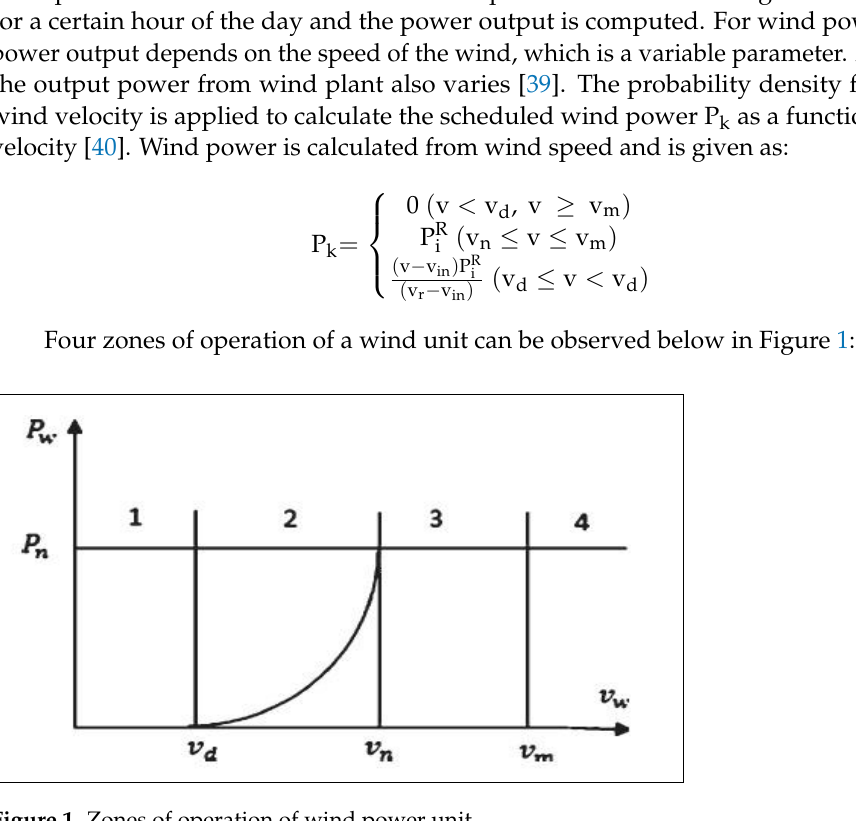
Figure 1. Zones of operation of wind power unit.